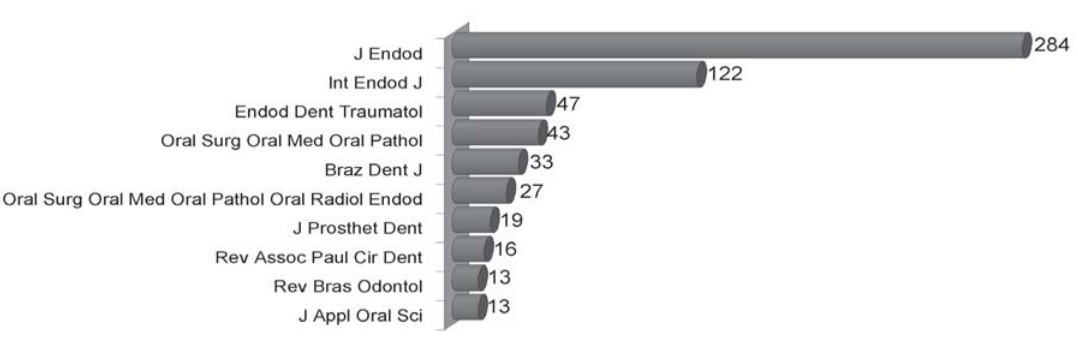
FIGURE 3- Journals of the area of Endodontics most frequently cited in the JAOS between 2005 and 2007